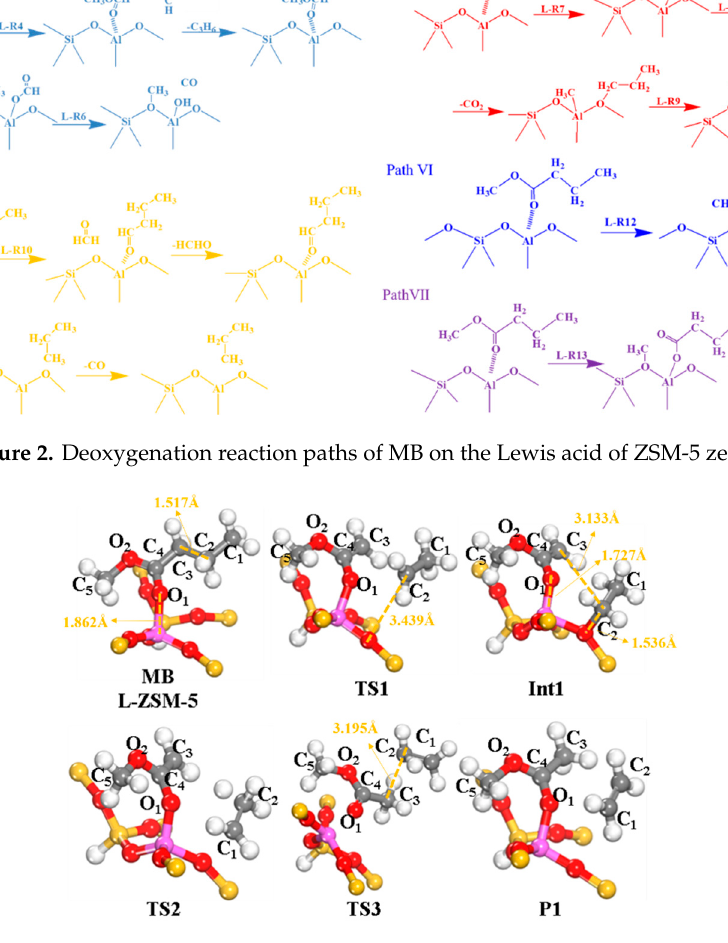
Figure 3. The structures of initial, transition, and final states for the β -C–C bond cleavage of MB on 32 T cluster of ZSM-5.